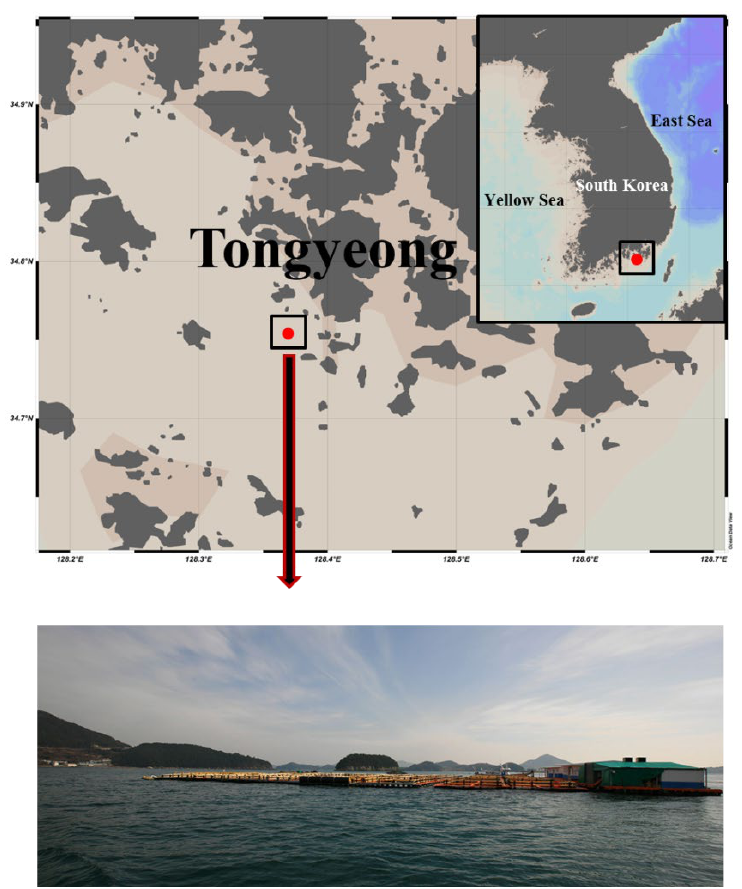
Figure 1. Map showing Tongyoung marine living resources station, Tongyeong, Gyeongsangnam-do, South Korea.